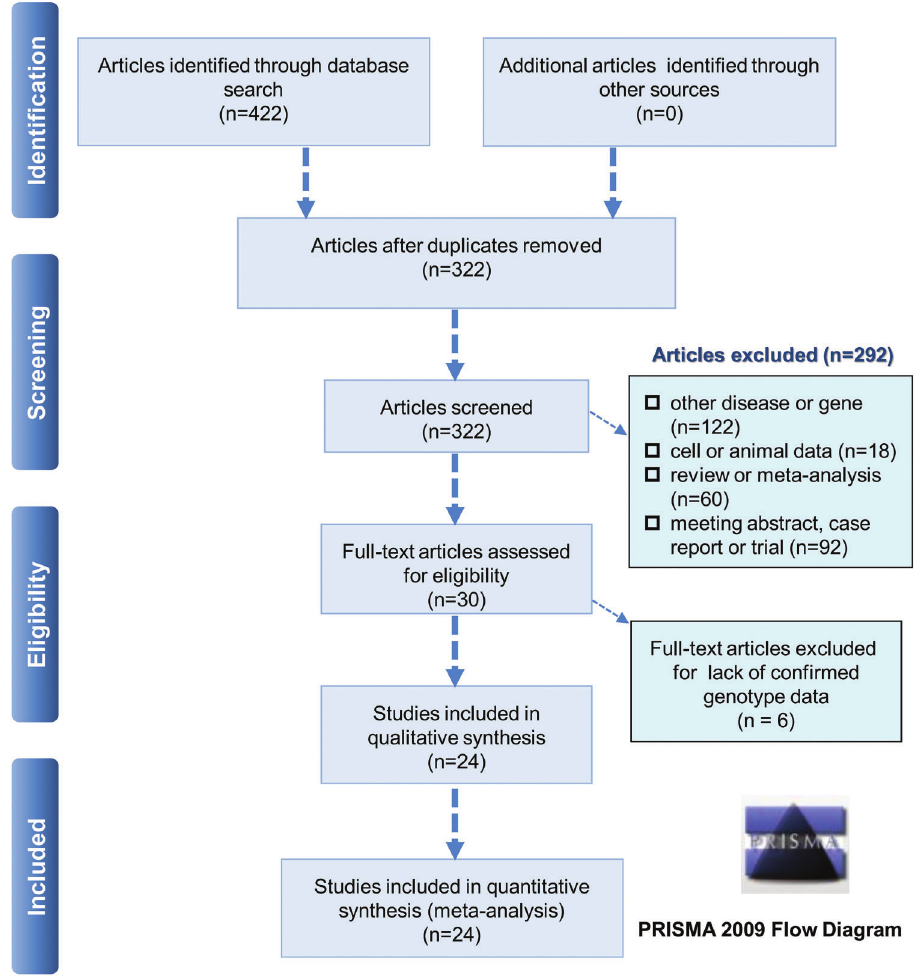
Figure 1. Flow diagram for identifying eligible case-control